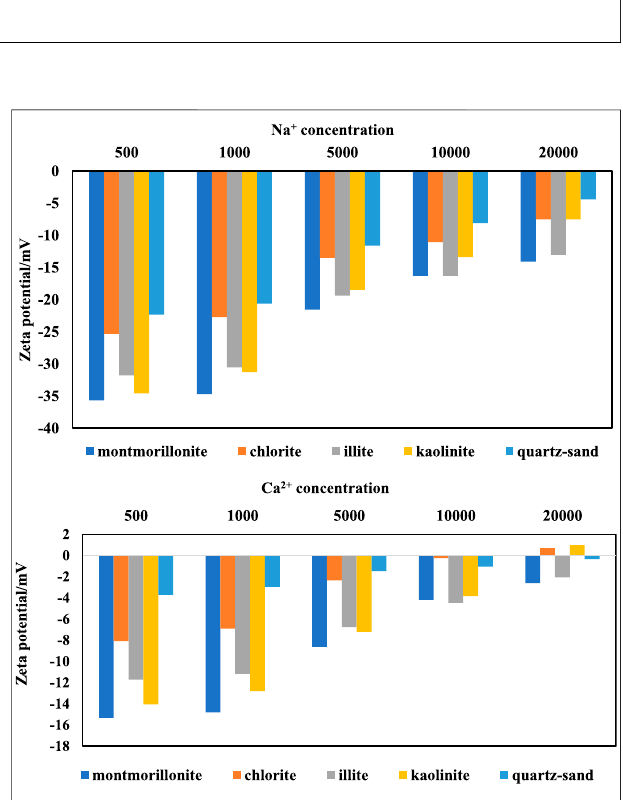
FIGURE 3 | Zeta potential of different kinds of clay